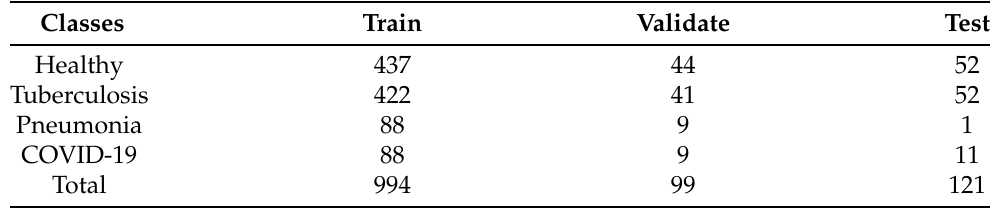
Table 11. Multiclass prediction data summary of the number of training set, validating set, and testing set samples in the multiclass X-ray image